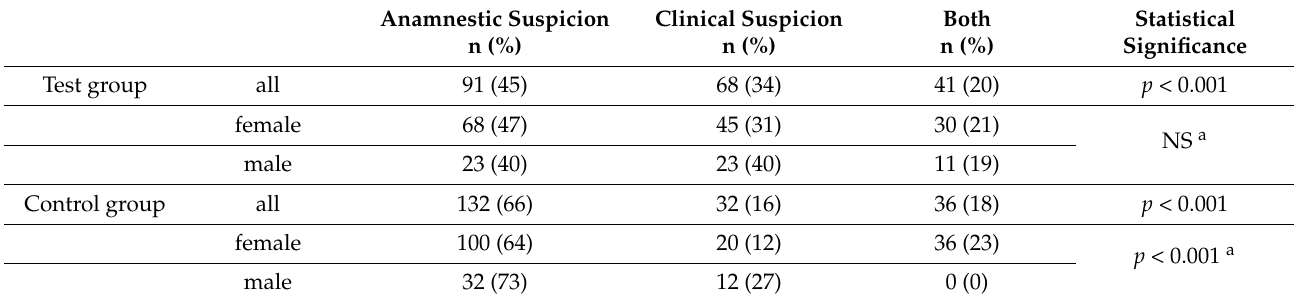
Table 3. Patient comparison by rhythm disorder